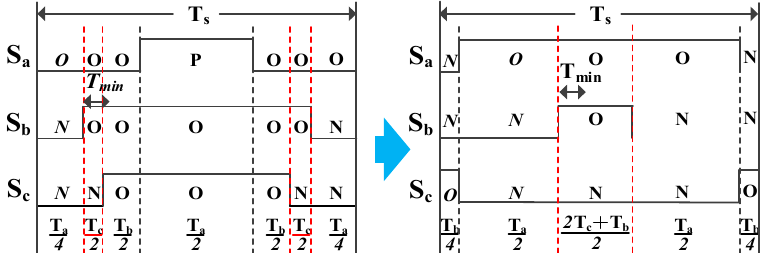
Figure 10. Switching sequences in conventional SVPWM and modified voltage modulation method. (Area 2).